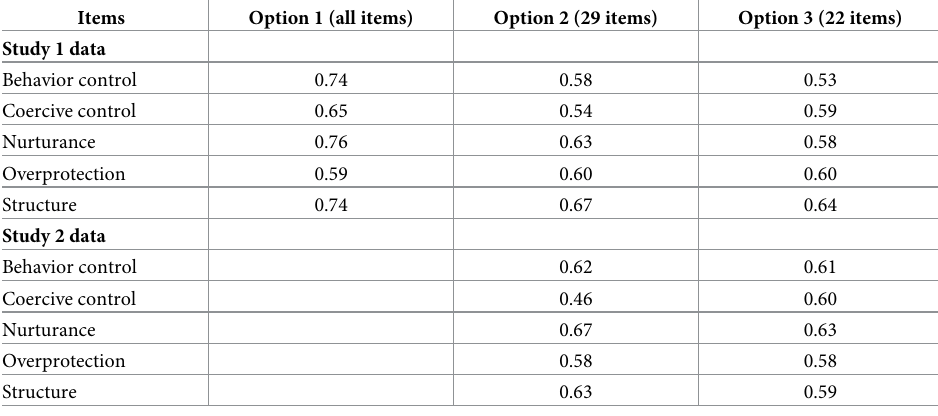
Table 2. Internal consistency–Cronbach’s alpha per construct considering three versions; all 69 items, 29 items, and 22 items (Study 1 and Study 2 data).